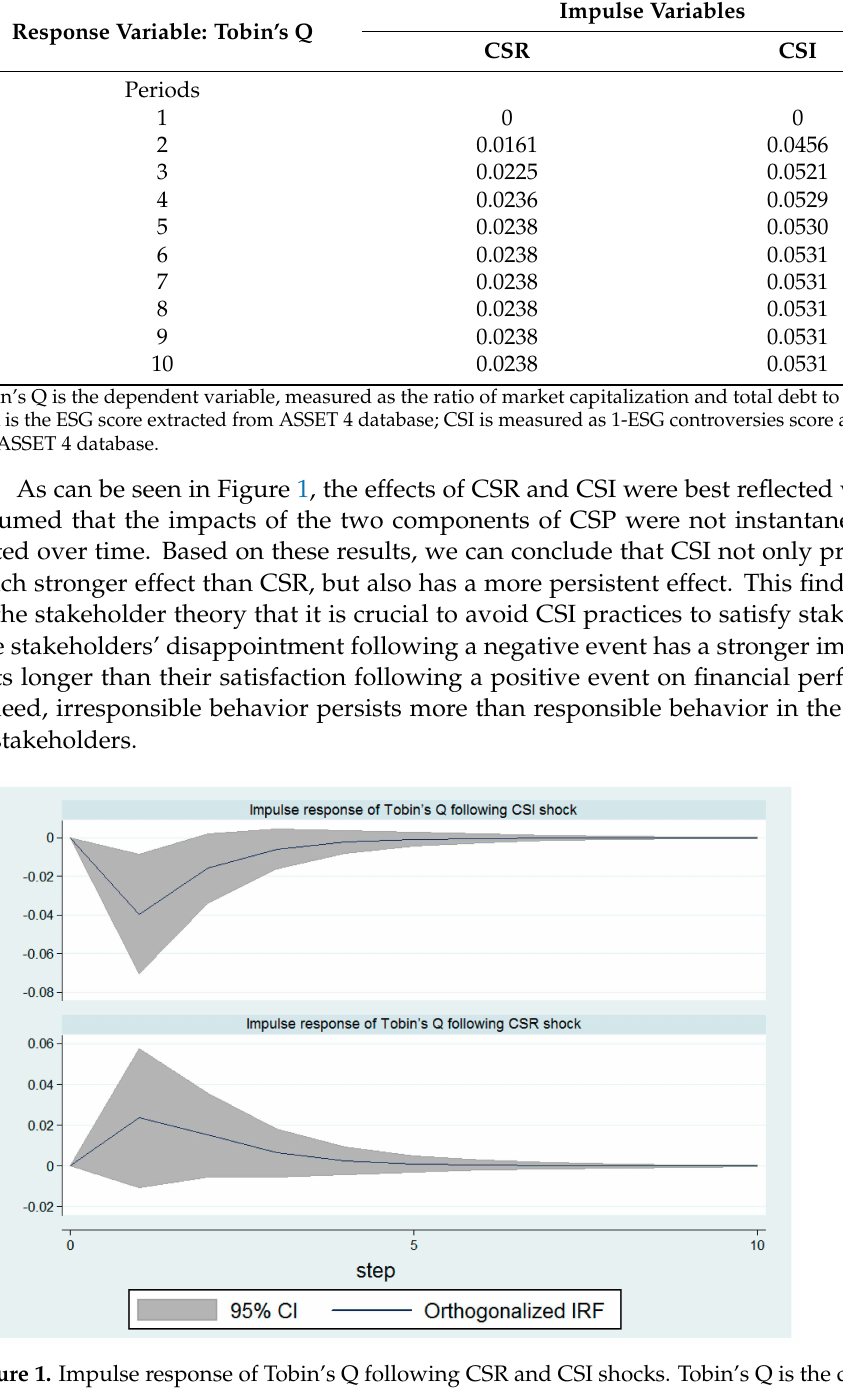
Figure 1. Impulse response of Tobin’s Q following CSR and CSI shocks. Tobin’s Q is the dependent variable, measured as the ratio of market capitalization and total debt to total assets; CSR is the ESG score extracted from ASSET 4 database; CSI is measured as 1-ESG controversies score available on the ASSET 4